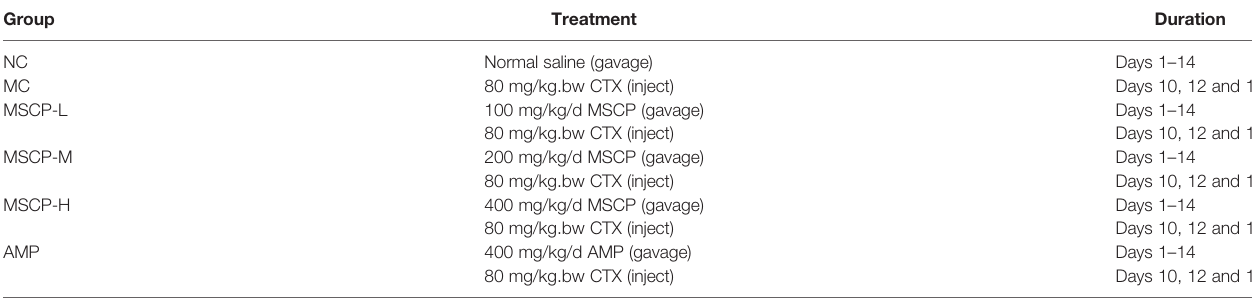
TABLE 1 | Different treatment groups in